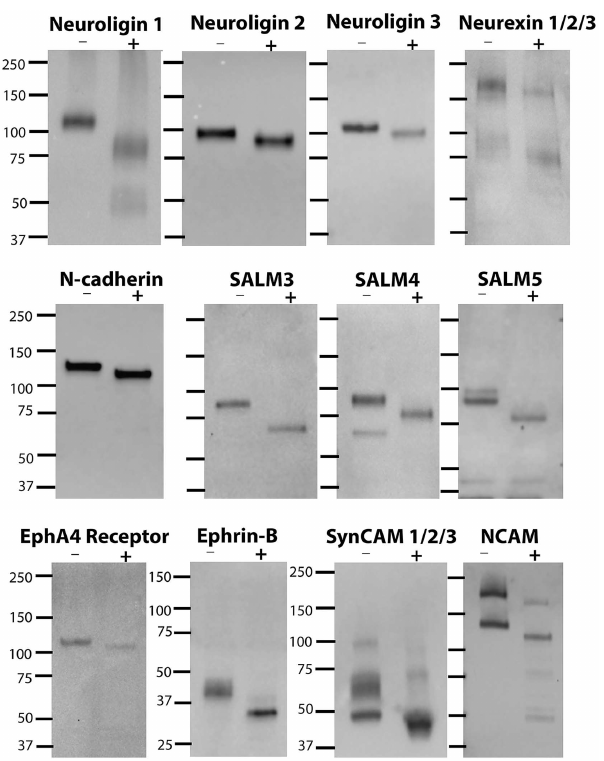
Fig 4. All tested cell adhesion molecules are glycosylated in the SJ fraction. Synaptic junctionfractions were incubatedwith (+) or without (-) a cocktail of glycosidases(Sigma). All proteins tested in the SJ fraction show a shift in mobility after treatment with